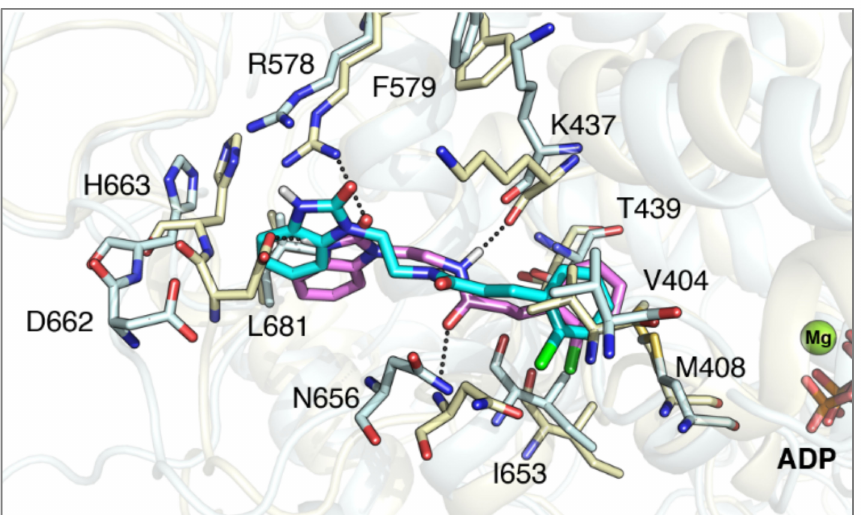
Figure 8. Compound 9 (INF120) in Med3 before and after MD simulation. Alignment of 9 (INF120) docking pose (pink) and 9 pose in the last frame of the MD simulation (cyan). Protein (docking: light yellow; post MD: light cyan) is represented as cartoon, residue side chains, ADP molecule, and 9 (pink) are shown as sticks, Mg ion is depicted as a green sphere. Residues, ADP and Mg ions are labelled. Hydrogen bonds are reported as dashed black lines. For clarity, only polar hydrogens of 9 are